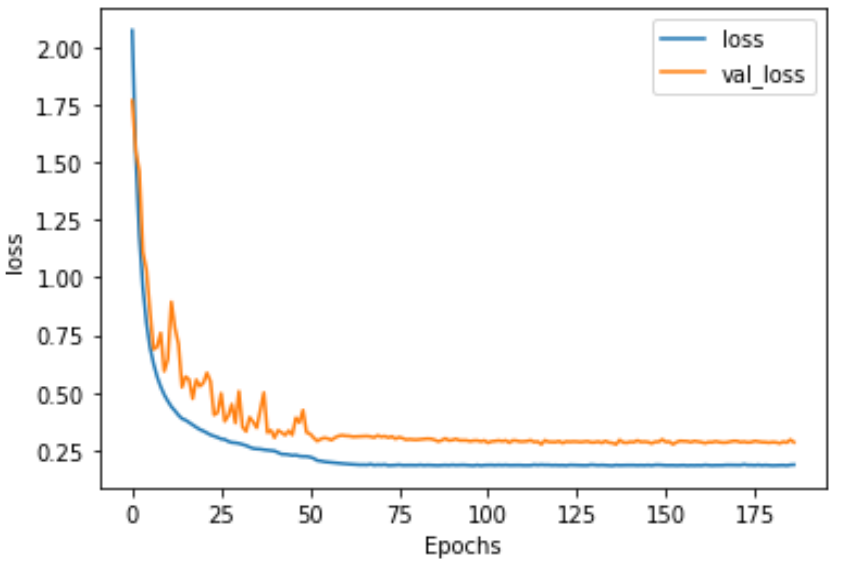
Figure 7. Loss curve for the MoNuSeg